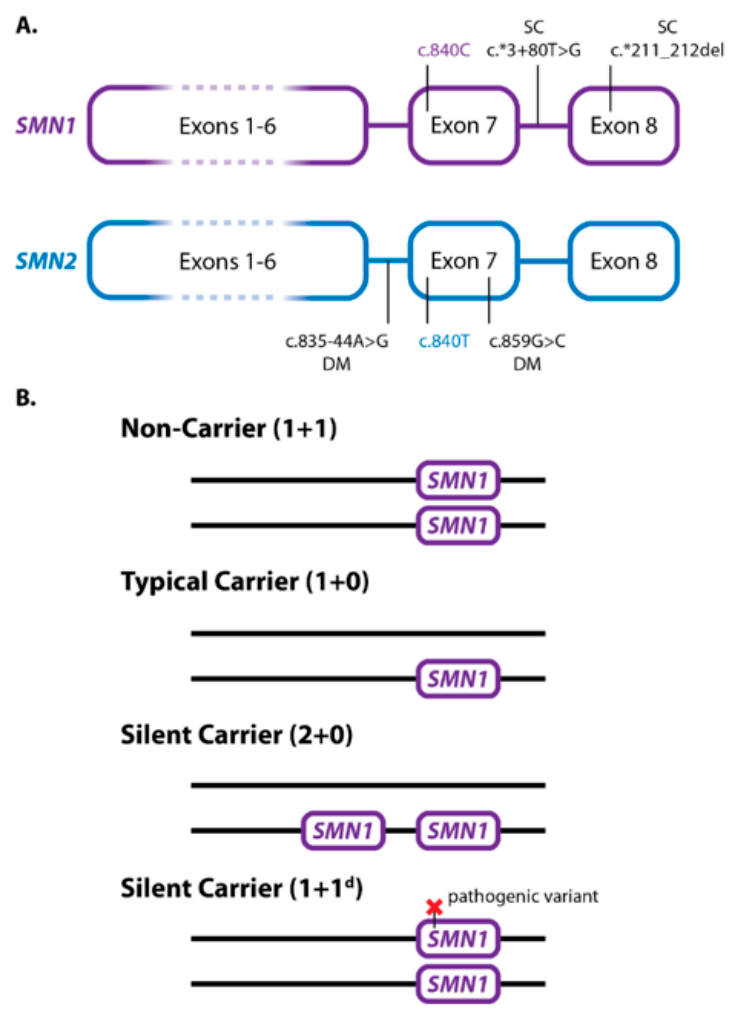
Figure 1. Genetics of SMN1 , SMN2 , and SMA Carriers . ( A ) Silent carriers and disease-modifying variants in SMN1 and SMN2 . Nucleotides at position c.840 in exon 7, typically used to distinguish SMN1 and SMN2 , are indicated by color (PSVs). Gene duplication variants in SMN1 associated with 2 + 0 silent carriers are indicated by the letters SC. Common disease modifier variants in SMN2 are indicated by the letters DM. ( B ) SMA carrier genetics. Non-carriers typically have one copy of SMN1 on each chromosome. Typical carriers have only one SMN1 copy, lacking SMN1 on the other chromosome. Silent carriers (2 + 0) often have two copies of SMN1 on a single chromosome, lacking SMN1 on the other chromosome. Silent carriers can also have one copy of SMN1 on both chromosomes but with a pathogenic variant in one copy.